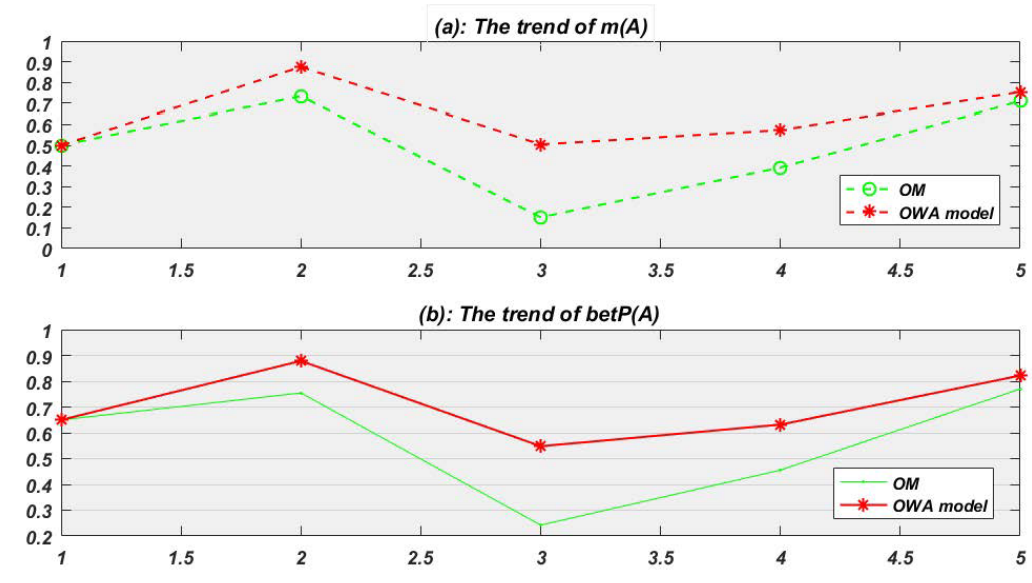
Figure 5. Results of Example 5. Table 3. BPAs from sensors in Example